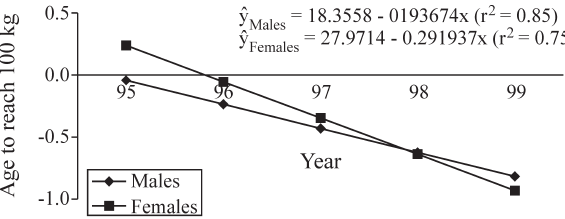
Figure 2 - Direct genetic trends for age to 100 kg from 1995 to